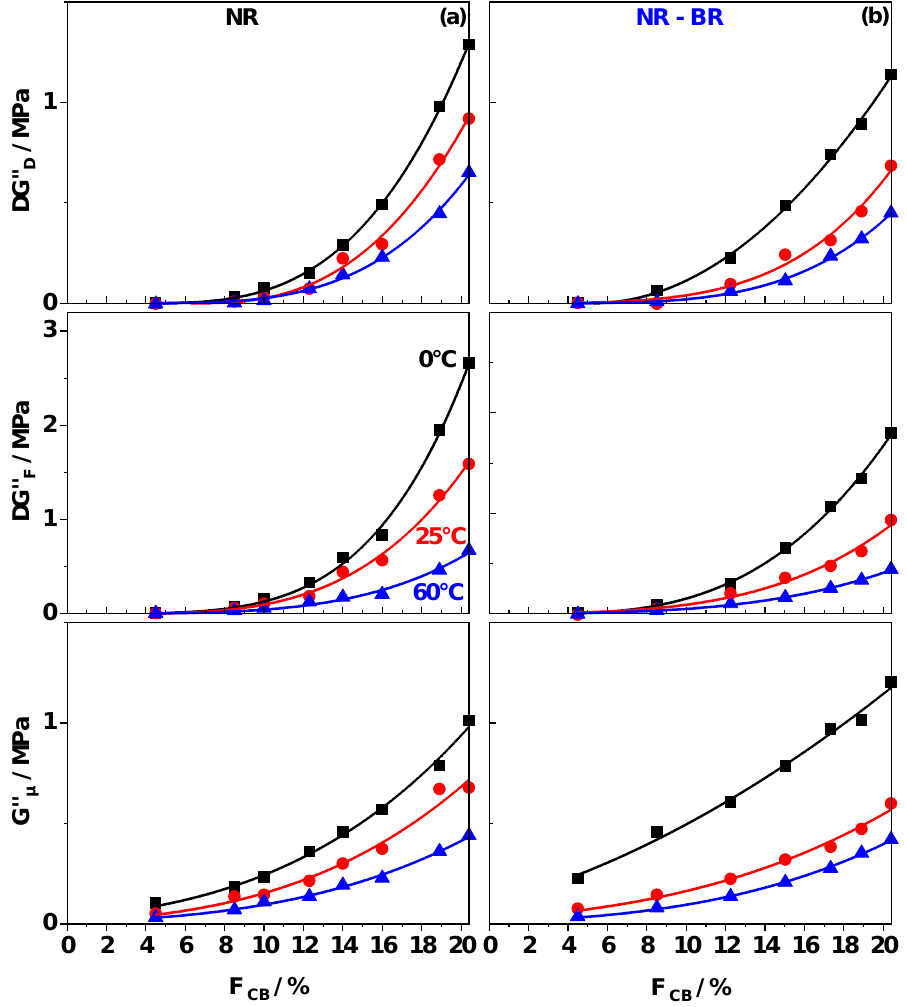
Figure 4. Filler fraction dependence of ∆ G (cid:48)(cid:48) three different temperatures 0 ◦ C (squares), 25 ◦ C (circles) and 60 ◦ C (triangles). Lines connecting the points is a guide to the eye